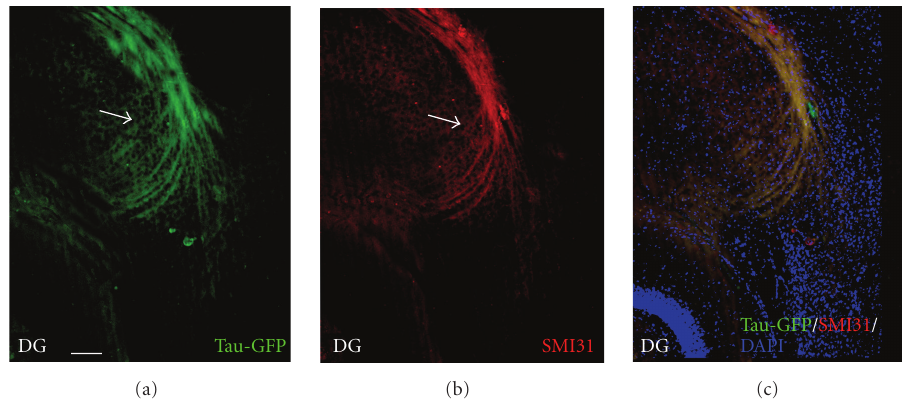
Figure 4: Another projection from neurosphere-derived cells towards the lesioned entorhino-hippocampal formation. The location of the dentate gyrus (DG) is indicated in a–c. (a)–(c) A GFP-positive fiber bundle in the area of hippocampal fissure with coexpression of SMI-31. Fibers end in the region of the hippocampal fissure. (a) Tau-GFP. Scale bar = 50 μ m. (b) SMI-31 staining. (c) Combined